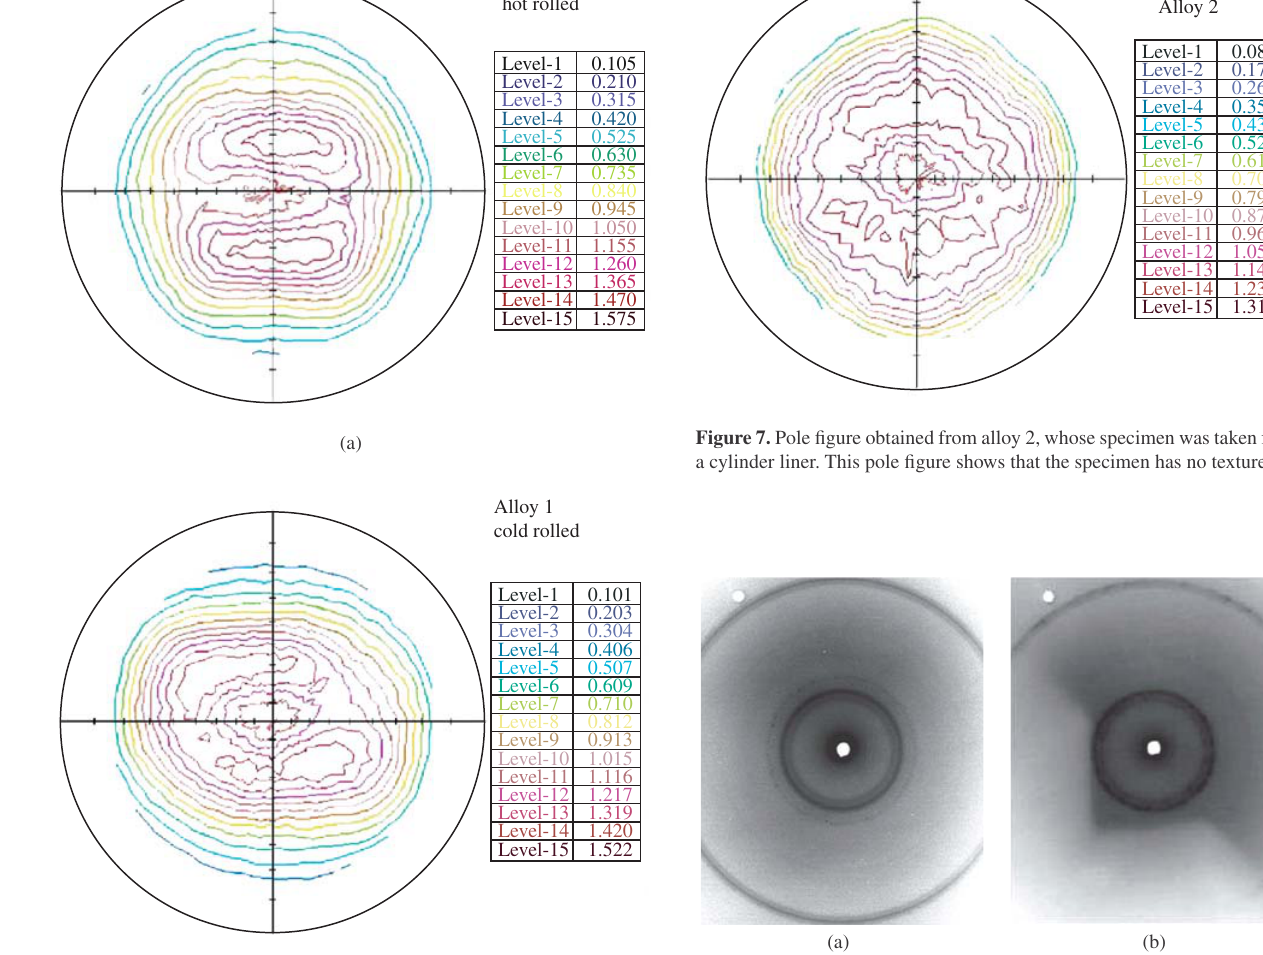
Figure 8. Laue photographs of the specimens taken from alloy 3. a) Radial direction. b) Axial direction. In the radial direction, the Debye rings are continu- ous and of uniform intensity and these are due to the incident X-ray beam to be parallel to the fibre axis. In the axial direction, the non-uniform blackening of the Debye rings is due to preferred orientation in the specimen.